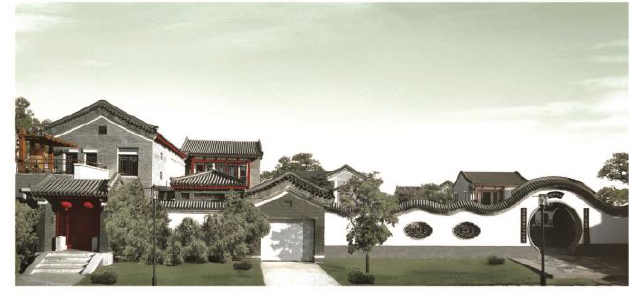
Figure 11. Computer-rendering of Guantang courtyard garden villas, incorporating traditional Chinese moon gate and lattice windows. Source: Beijing Institute of Architectural Design 2014.